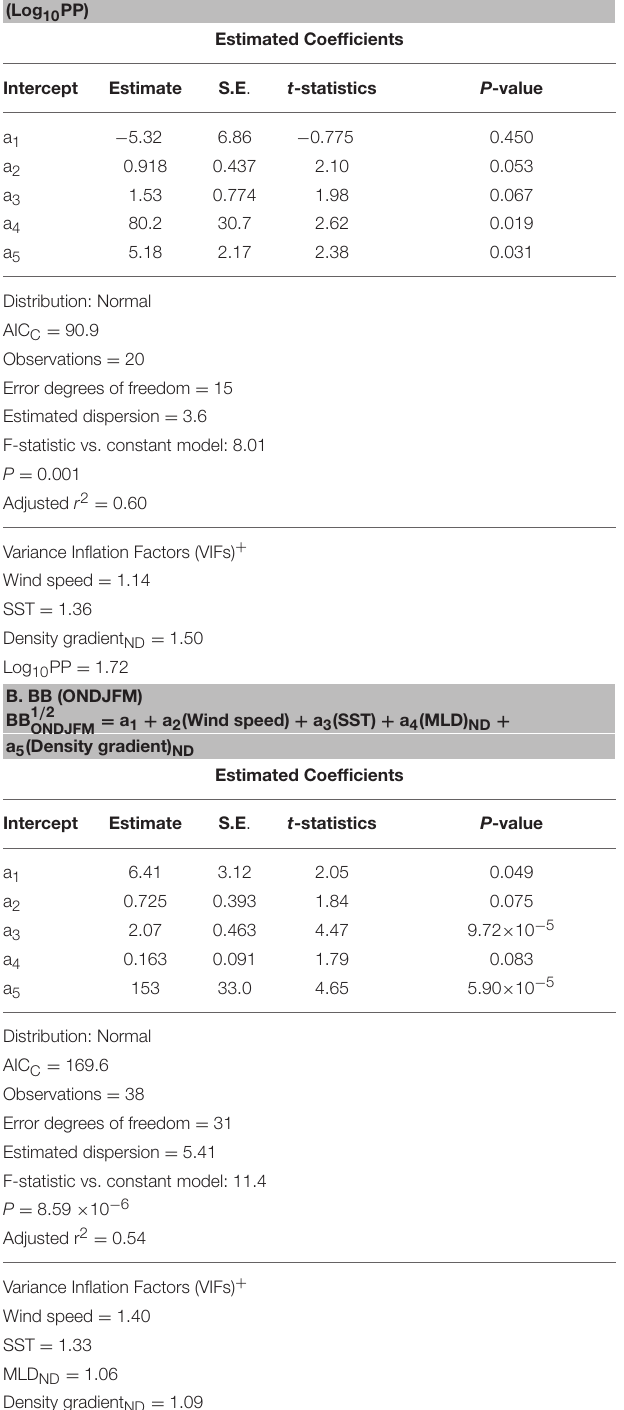
TABLE 2 | Summary of generalized linear models (GLMs) and associated statistics for monthly composites of BB during summertime only (A) and during entire growing seasons